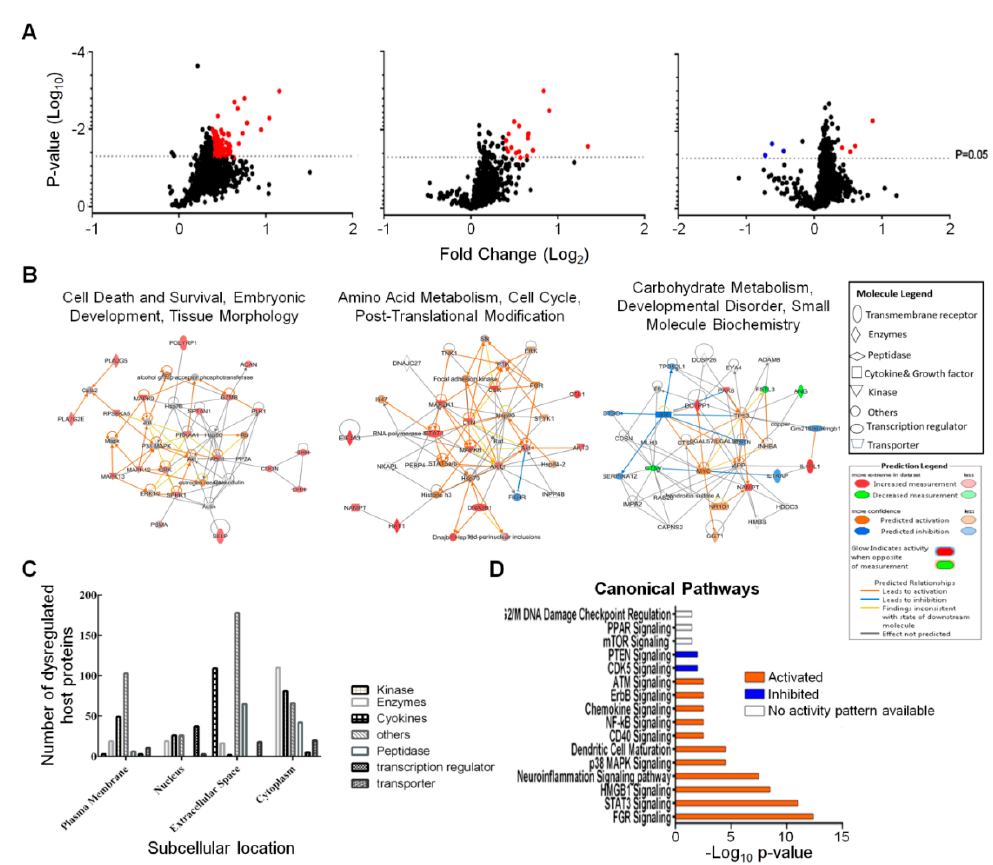
Figure 2. Zika virus dysregulated Caco-2 proteins and predicted signaling pathway. ( A ) Volcano plots showing fold changes and p -values of Caco-2 proteins at each time point. Red dots are significantly upregulated proteins. The three blue dots in the 48 h plot are significantly downregulated. ( B ) IPA-determined interaction networks and focus molecules of top diseases and functions predicted to be affected after ZIKV infection. Orange proteins are upregulated, whereas downregulated proteins are green. Predicted pathway activations and inhibitions are depicted in orange and blue, respectively. ( C ) Subcellular locations of dysregulated host proteins and the nature of these proteins. ( D ) Bar charts showing signaling pathways predicted by IPA to be induced after 12 h of ZIKV infection. Orange bar and blue bars indicates activation and inhibition of pathways after infection, respectively. Clear bars indicate no activity prediction by IPA based on Z score. Table 2. List of significantly dysregulated Caco-2 proteins after ZIKV infection.